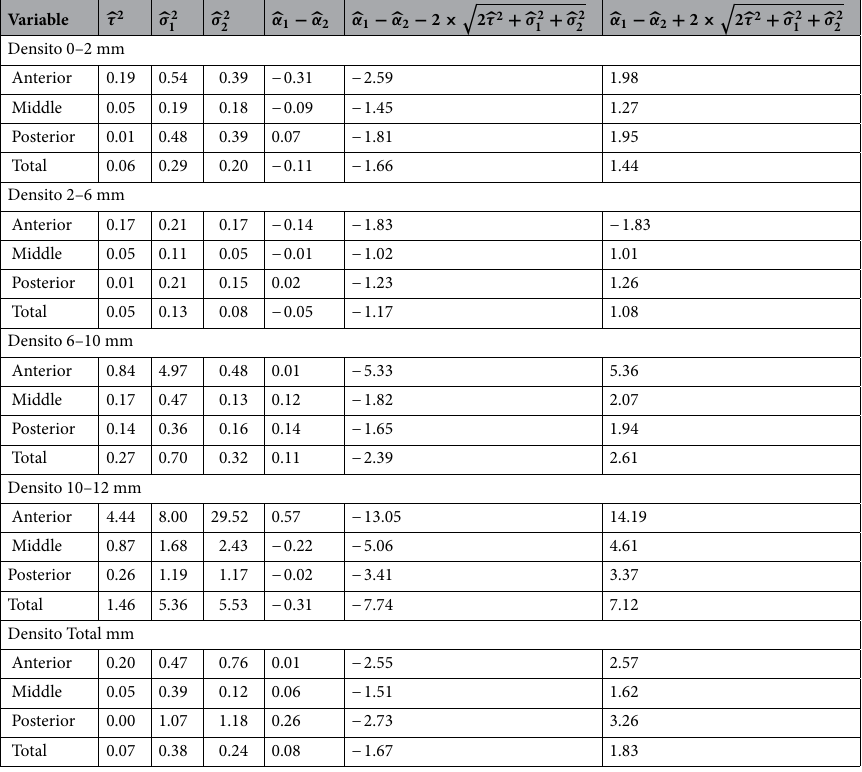
Table 3. Prediction limits for differences between single measurements in subjects with keratoconus. The values are given in greyscale